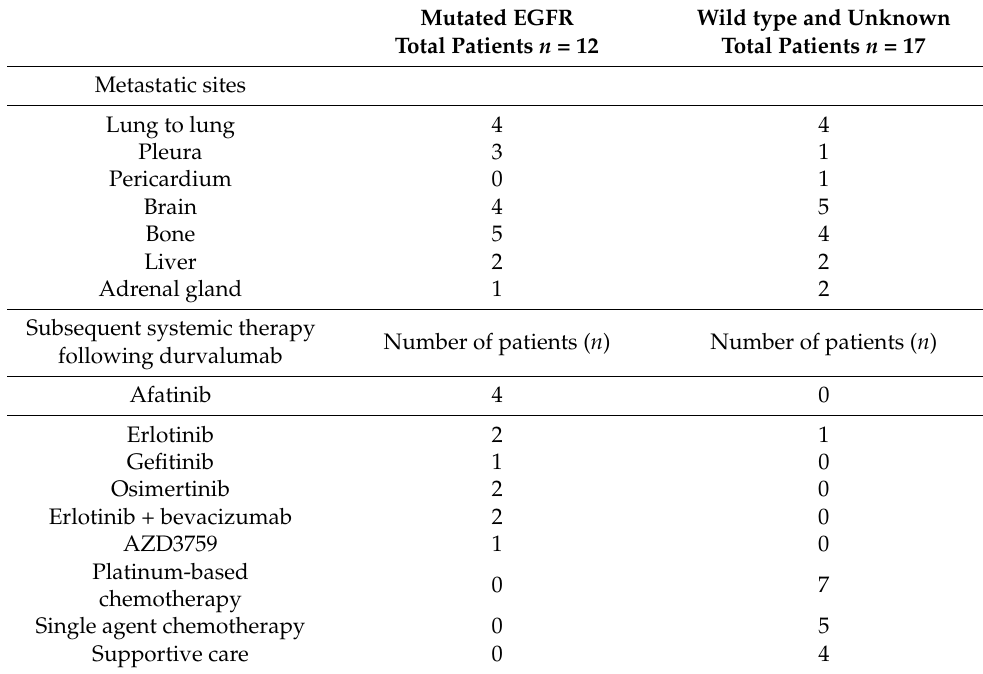
Table 4. Metastatic sites and subsequent systemic therapy following durvalumab in patients with progressive